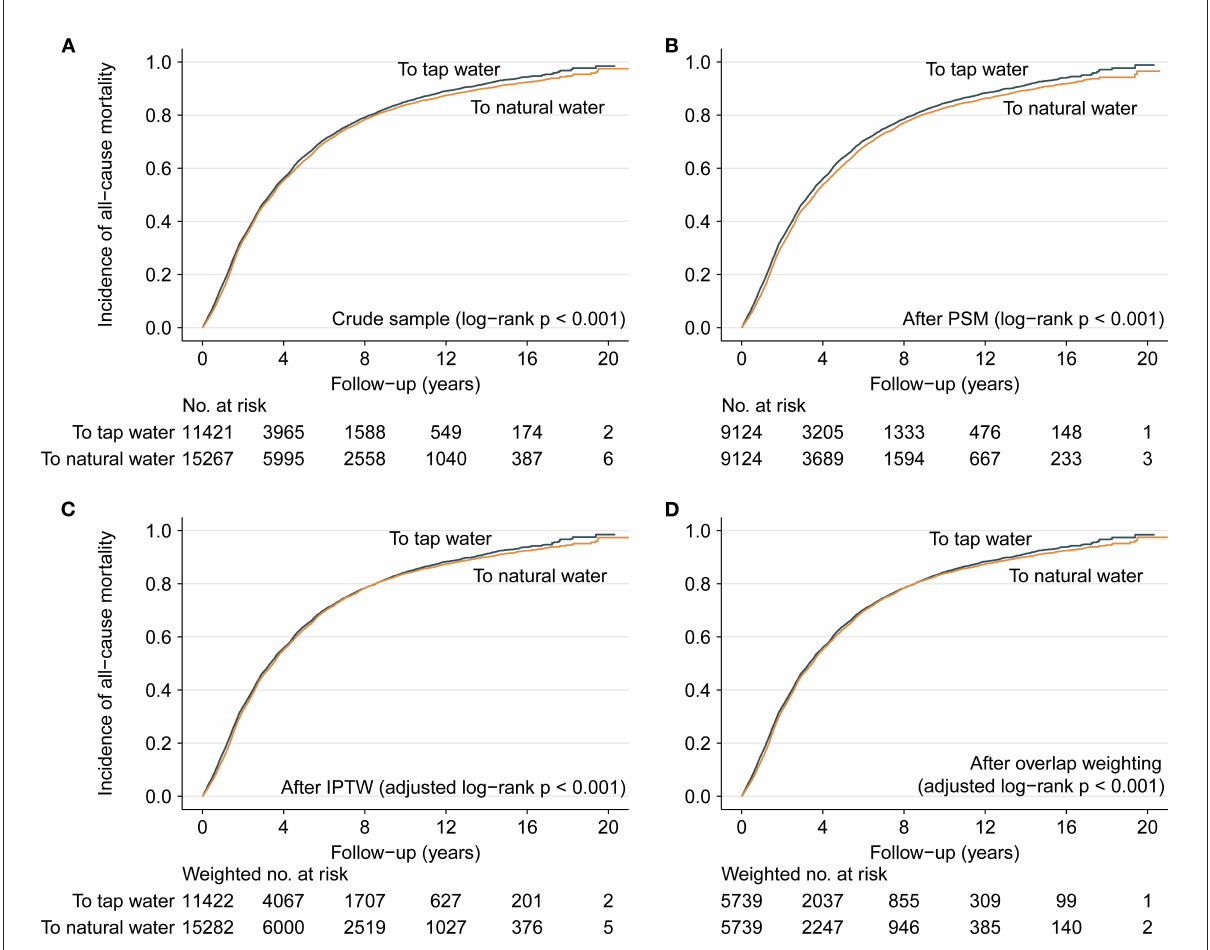
FIGURE4 Cumulative incidence of all-cause mortality. (A–D) present Kaplan-Meier curves showing the participants with continued use of natural water had significantly lower cumulative incidence of all-cause mortality during the follow up in comparison with those switching to tap water later in the crude sample, PSM sample, IPTW sample and overlap weighting sample. In addition, the maximal difference of cumulative incidence was only 0.16% for the curves of “to tap water” between IPTW sample and overlap weighting sample at each same point of follow-up time, and the maximal difference was only 0.20% for the curves of “to natural water”; therefore, the curves were similar between (C,D)